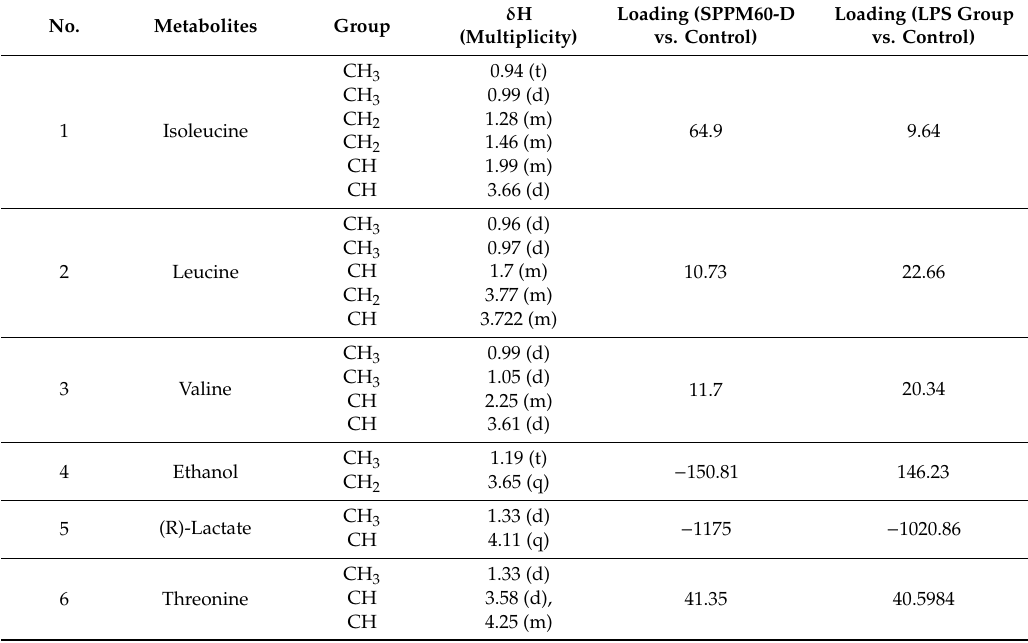
Figure 3. 1 H-NMR spectra of RAW264.7 cell from the LPS groups, SPPM60-D groups and control groups (The arrows show the differential metabolites in table 1). ( A ) The LPS group vs. Control group ( B ) The SPPM60-D group vs. Control group. Table 1. Nuclear magnetic resonance spectroscopy (NMR) data for RAW264.7